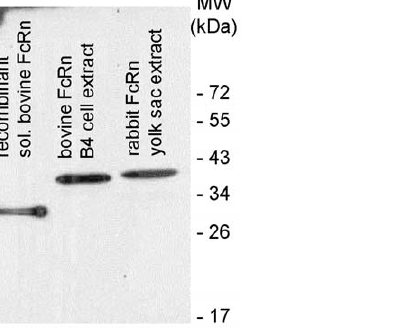
Figure 4. Detection of the rabbit FcRn in Western blot. This Western blot shows that the chicken antibody strongly and specifically reacted with the soluble recombinant bovine FcRn which was used for immunization (its estimated molecular weight is 30 kDa), a , 40-kDa band that is consistent with the known molecular weight of the bovine FcRn a -chain in the protein extract from a bovine FcRn stably transfected cell line (B4) [46] which strongly expresses the functional form of the bovine FcRn and a , 40-kDa band that is consistent with the calculated molecular weight of the rabbit FcRn a -chain in the protein extract from the rabbit yolk sac from 24 dpc